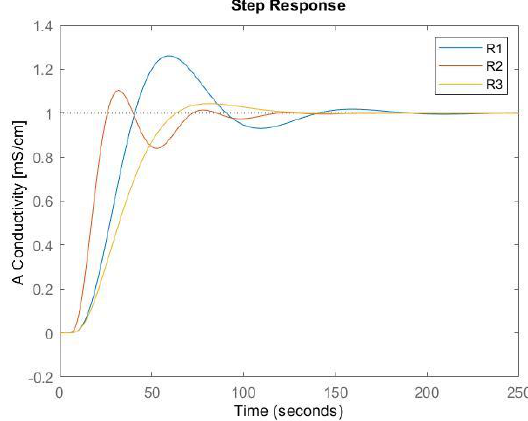
Figure 5. Step responses of the closed-loop system for the three designed PI controllers.